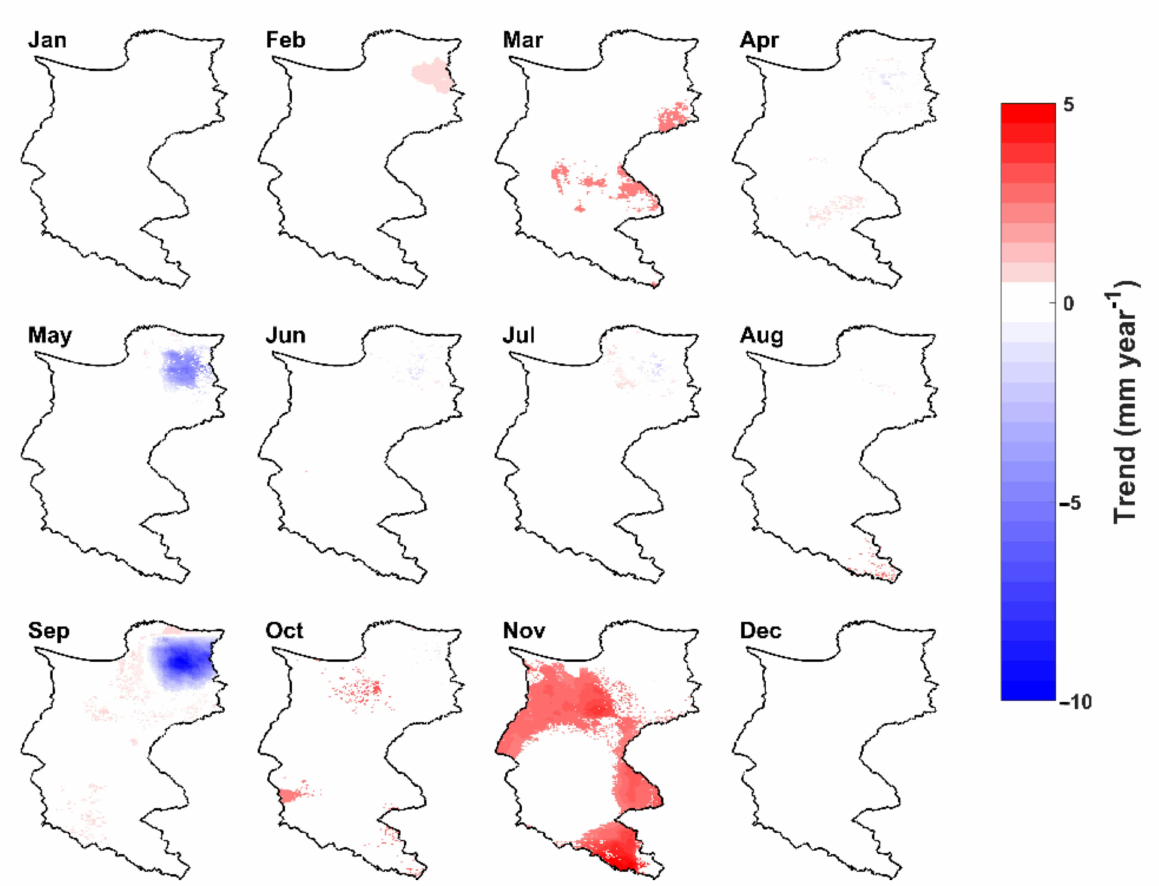
Figure 7. Statistically significant trends detected for the annual cycle of total precipitation in the Magdalena Department during the 1981–2018 period based on the CHIRPS v2.0